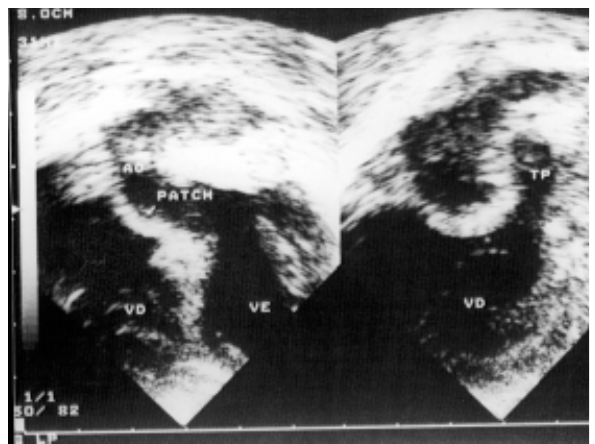
Fig. 4 – Post-operative echocardiogram demonstrating the absence of a left ventricle outflow tract obstruction The valved conduit grafted in patient Nº 1 was obstructed in the late echocardiogram.